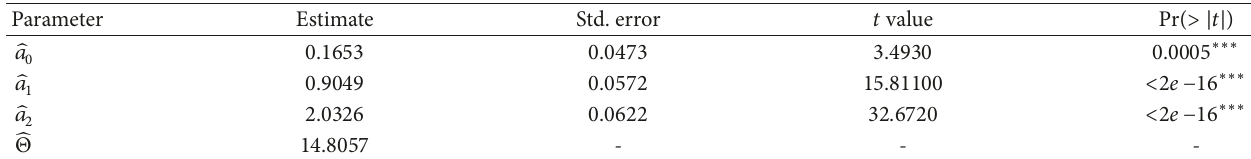
Table 1: Estimated parameter values.